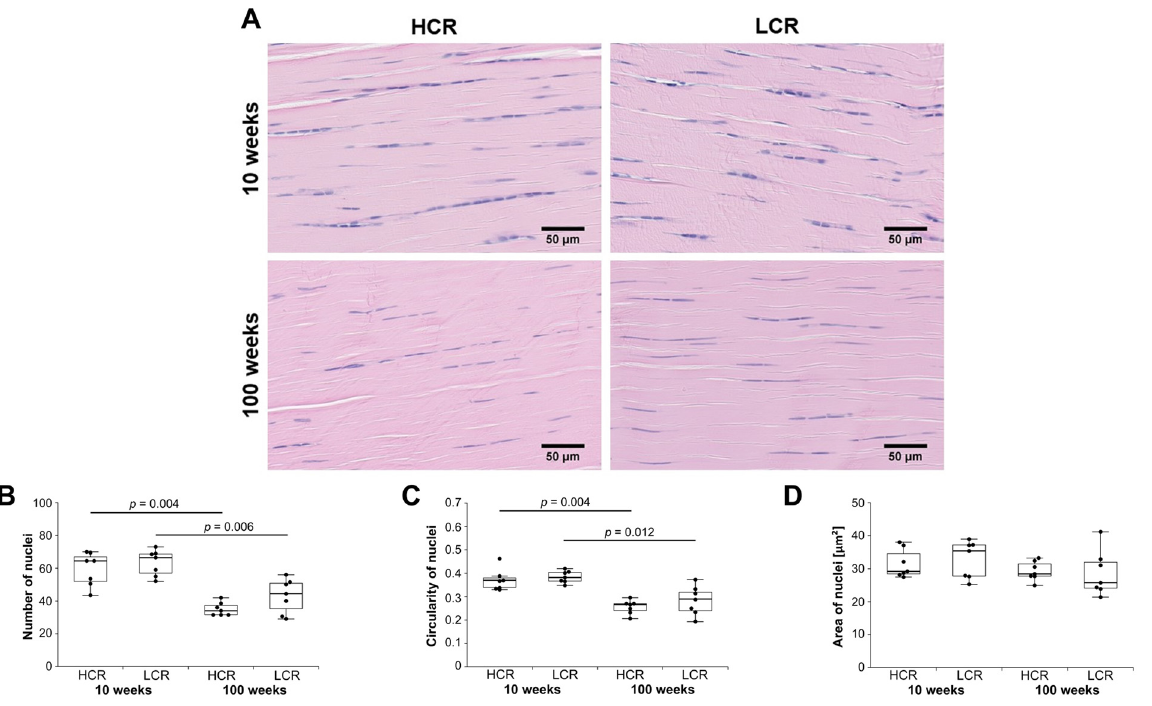
Figure 6. Evaluation of tenocyte nuclei. ( A ) Exemplary images of mid-portion Achilles tendon of young and old HCR and young and old LCR stained with hematoxylin and eosin (HE). Old HCR and old LCR showed a lower cellularity and more elongated tenocyte nuclei. Scale bar: 50 μ m. ( B ) Number of tenocyte nuclei, ( C ) circularity of tenocyte nuclei in which a value of 1 indicates a perfect circle and a value of 0 indicates a very elongated polygon, and ( D ) area of tenocyte nuclei in μ m 2 . Results are shown as box plots with individual data points. Significant differences between two groups are marked as a line spanning between them with the p -value displayed above. p ≤ 0.05 was considered statistically significant.